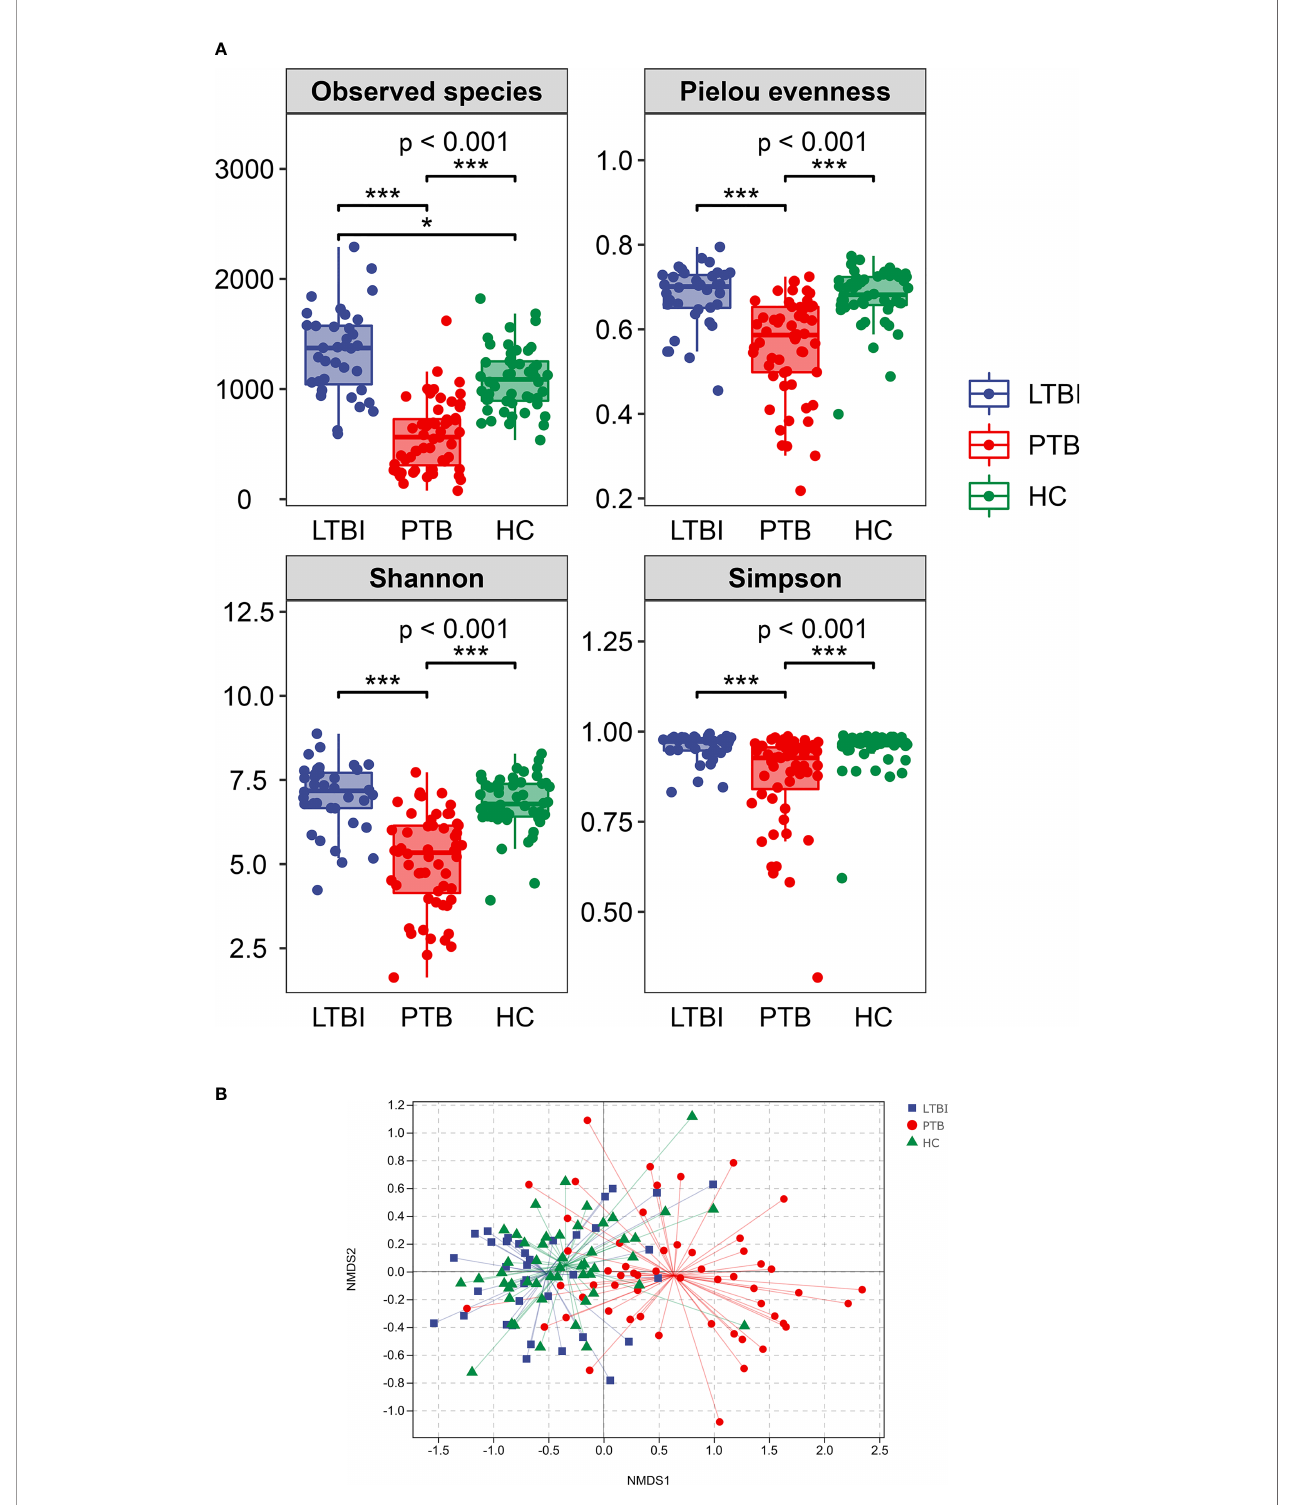
FIGURE 2 | Comparison of the intestinal microbiota richness and diversity in three groups. (A) The alpha diversity was assessed using the above indexes. The P-values of the overall difference between groups obtained by the Kruskal – Wallis nonparametric test, markers of difference signi fi cance levels obtained after pairwise comparison of Dunn ’ s test between groups (*P < 0.05, ***P < 0.001). (B) NMDS represent beta diversity, measured by unweighted unifrac, the differences in the microbiome composition among groups were assessed by